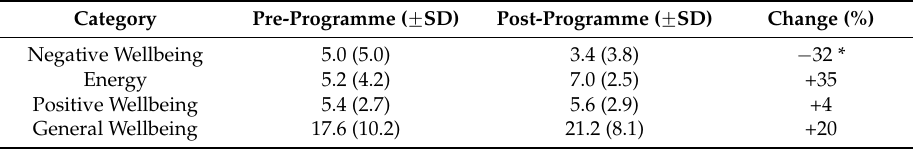
Table 3. Pre-post programme Well-being (WB12-Q) scores (± SD) and percentage changes. Category